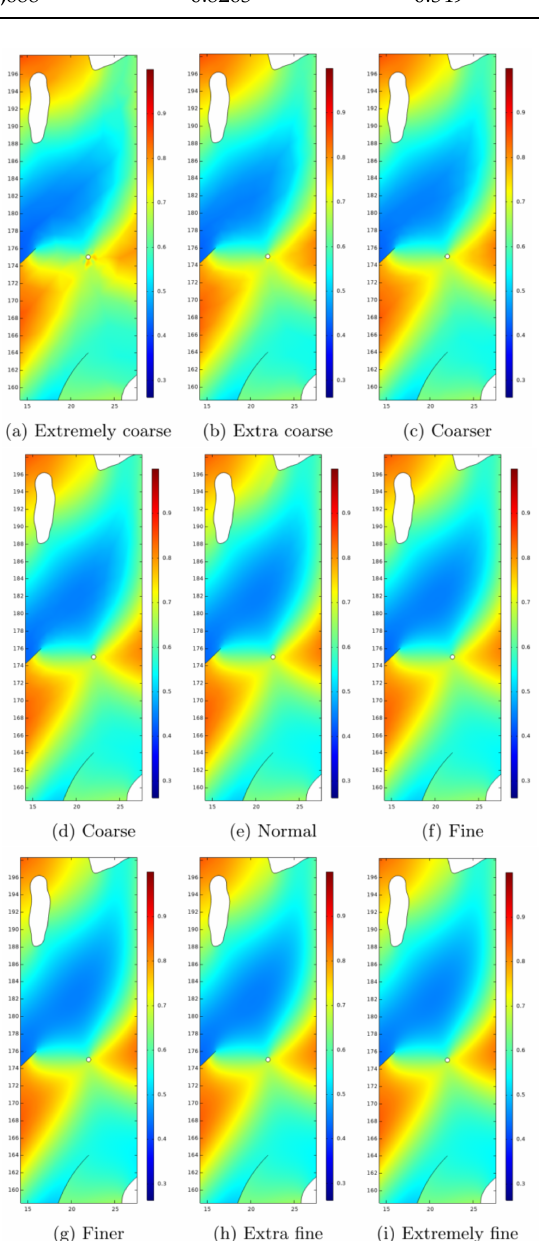
Figure 11. Normalized saturation in the north of the Ghawar field for different mesh